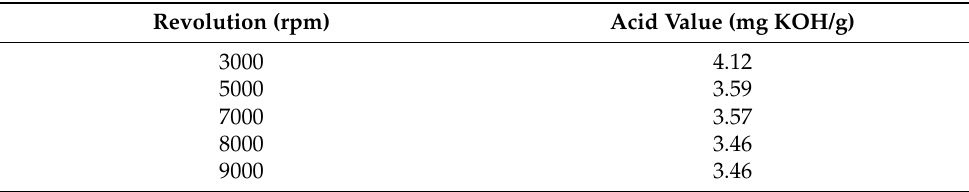
Table 1. Effect of rotational speed on the acid value.